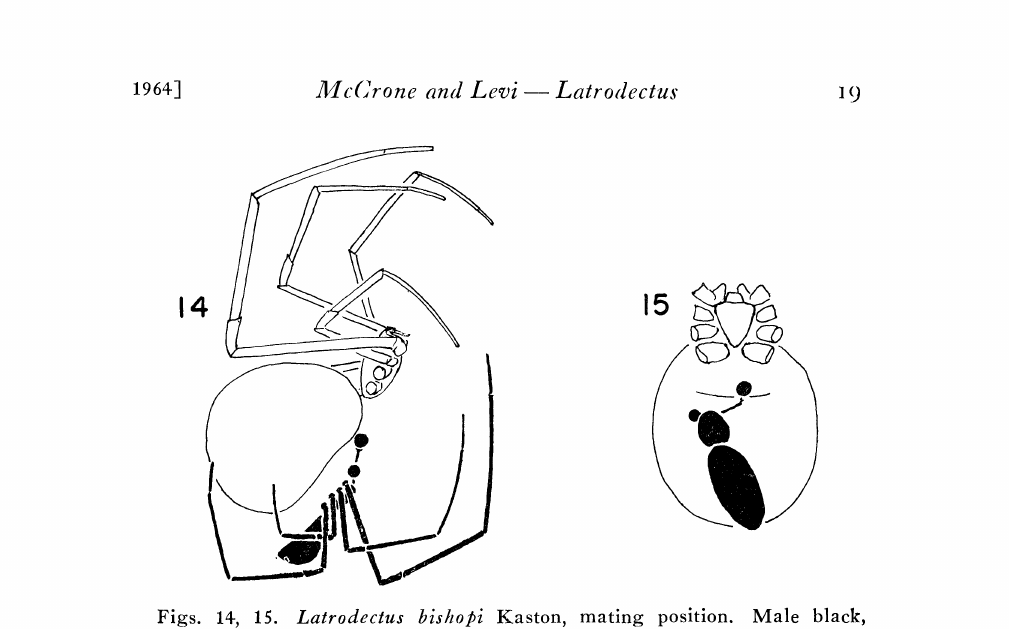
Figs. 14, 15. Latrodectus bishopi Kaston, mating position. Male black, female in outline. Web supporting the spiders not